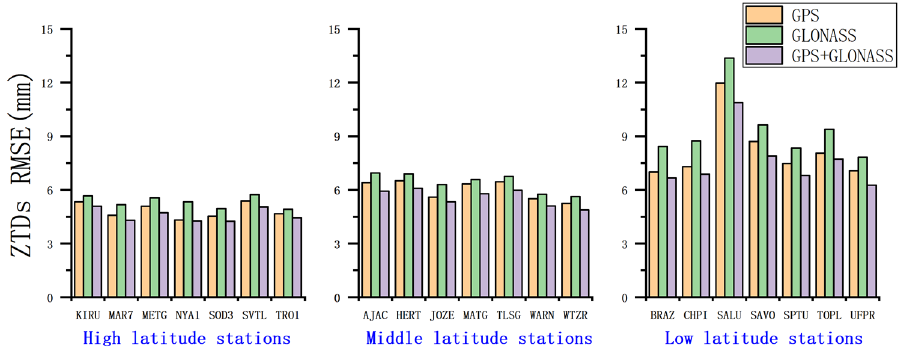
Figure 16. The RMSE of ZTDs estimated with PPP. Table 11. The mean RMSE of ZTDs estimated with the PPP of each network and their comparison between different processing modes (The positive red and negative green values indicate the percentage increment and reduction of accuracy, respectively).